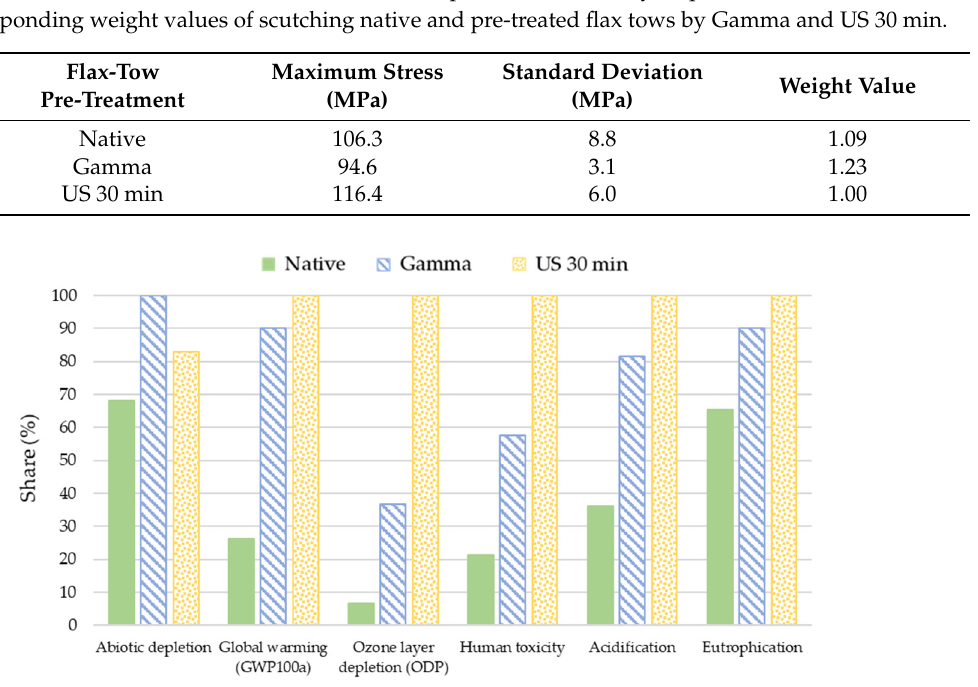
Table 4. Environmental impacts for the production of scutching native flax tows, flax tows pre- treated using the Gamma and US 30 min processes